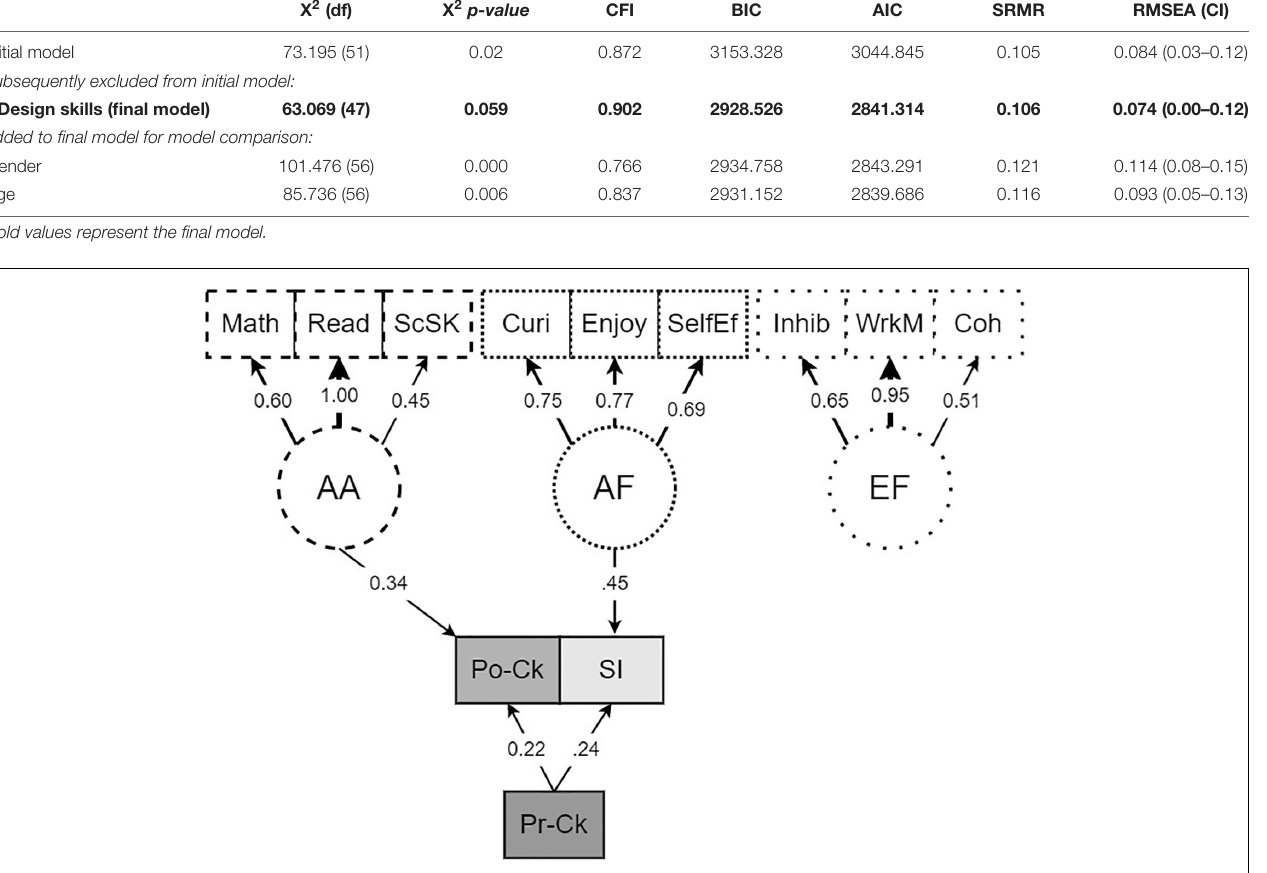
Frontiers in Education |